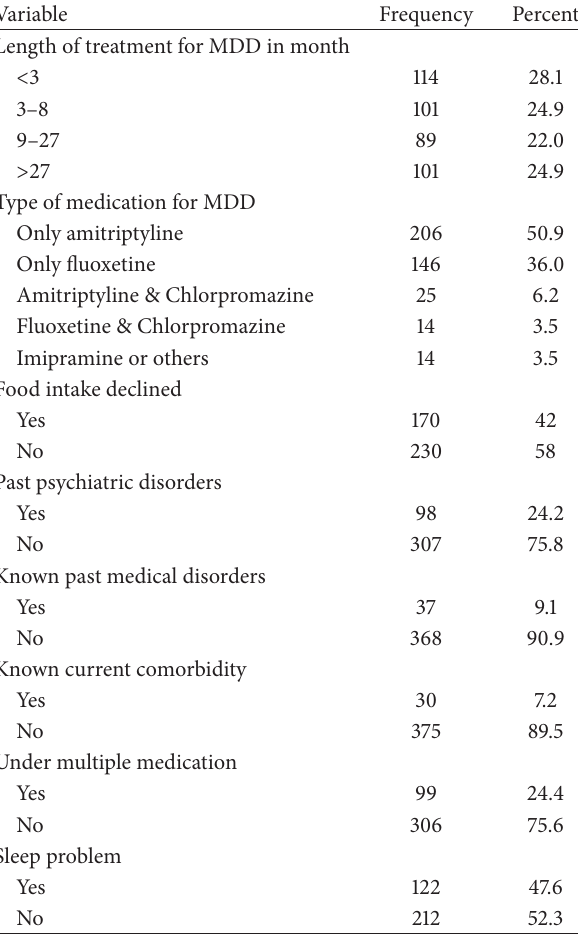
Table 3: Individual characteristics related to dietary and behavioral characteristics of respondents with major depressive disorder in University of Gondar Referral Teaching Hospital and Felege Hiwot Referral Hospital, Northwest Ethiopia, 2015 ( 𝑛 = 405